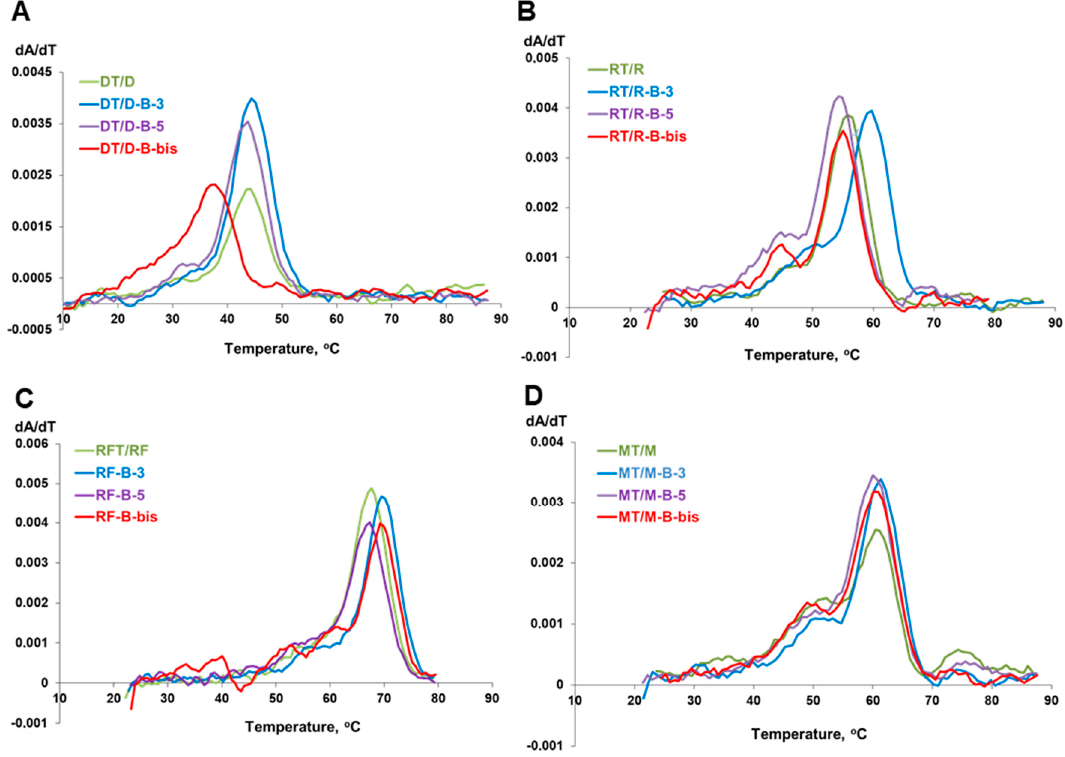
Figure 5. Melting curves of the duplexes formed by oligonucleotide conjugates with closo -dodecaborates and their com- plements: DNA ( A ), RNA ( B ), 2 ′ -F-RNA ( C ), and 2 ′ -O-Me-RNA ( D ). For each panel, green curve—control duplex of parent non-conjugated oligonucleotide, blue curve—duplex of 3 ′ -conjugate, violet curve—duplex of 5 ′ -conjugate, red curve— duplex of dual 3 ′ ,5 ′ -conjugate. Conditions: 10 mM sodium phosphate (pH 7.5), 2 µM oligonucleotides. Table 2. The values of melting temperatures for homo- and hetero-duplexes of oligonucleotide conjugates and parent oligonucleotides.